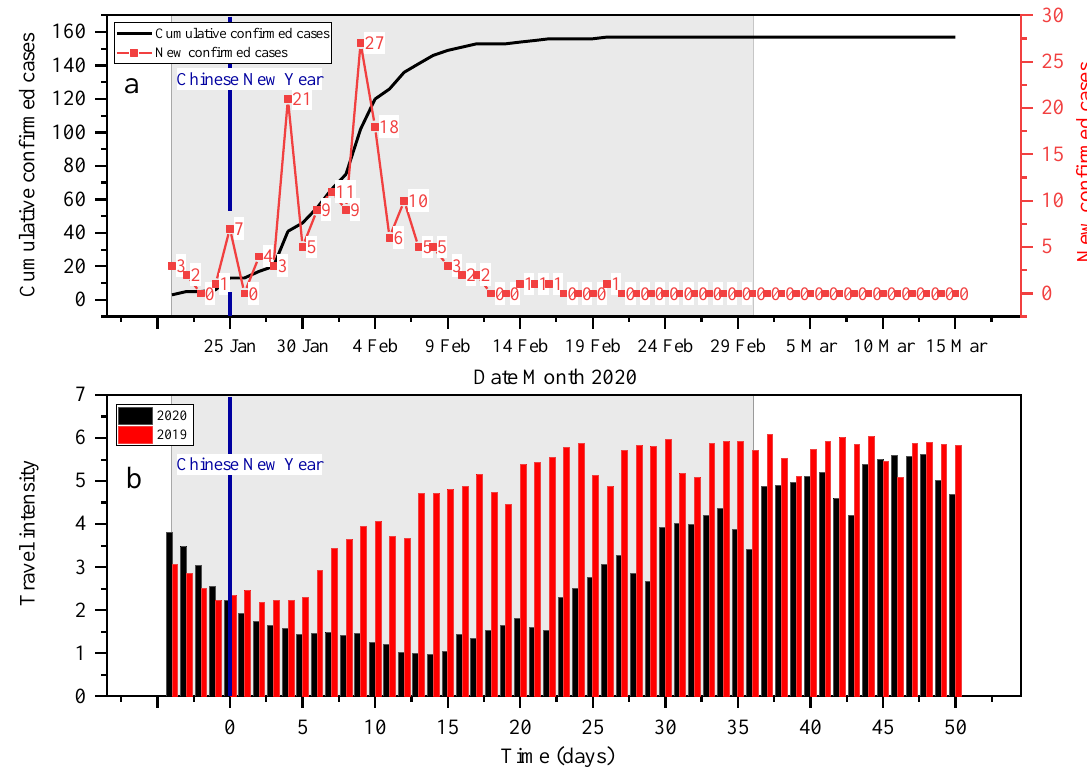
Figure 2. ( a ) Cumulative confirmed COVID-19 cases and daily new confirmed cases in Ningbo. The shaded area shows the period during the lockdown. ( b ) Comparison of travel intensity of Ningbo between 2020 and 2019. The Chinese New Year in the figure shows that of 2020 and 2019, which are compared according to the Chinese lunar period. The x-axis is the number of days relative to the Chinese New Year. Travel intensity refers to the indexation result of the ratio of the number of people traveling in the city to the resident urban population. The shaded area shows the period during the lockdown. The economic situation of Ningbo was significantly affected by the lockdown in the first quarter of 2020 (http://tjj.ningbo.gov.cn/ (accessed on 1 November 2020)) (Table 3). Table 3. The economic indicators of Ningbo in the first quarter of 2020 compared with those in the first quarter of 2019. First-Quarter, Economic Indicators (Unit) Electricity consumption of the whole city (100 million kwh)